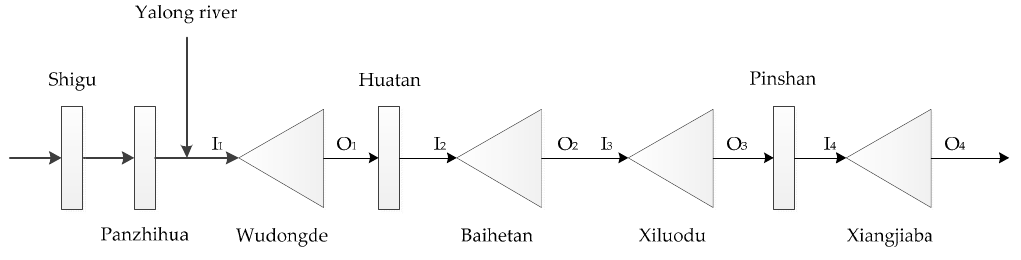
Figure 2. Topology of hydrological stations in the Jinsha River.